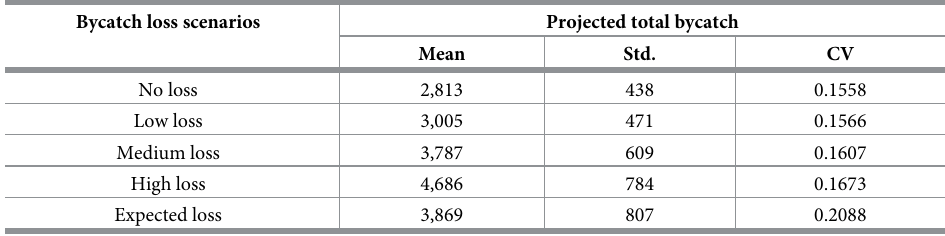
Table 4. Mean, standard deviation (std.) and coefficient of variation (CV) of projected fleet level total (1992– 2016) seabird bycatch from different bycatch loss scenarios in the Western North